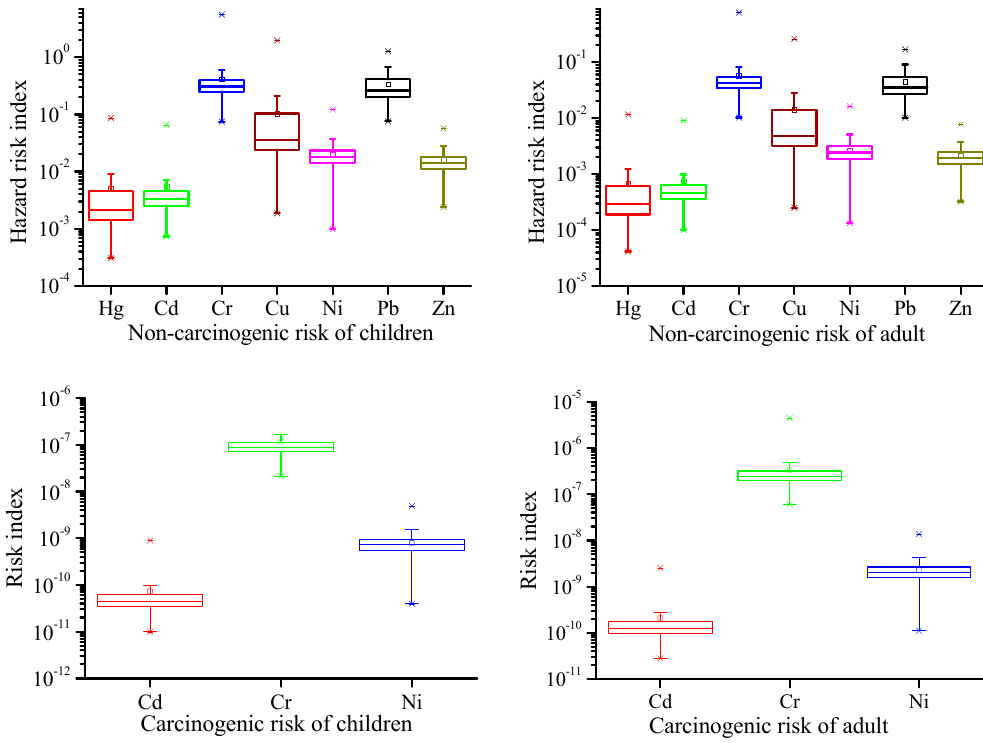
Figure 4. Non-carcinogenic and carcinogenic hazard index for heavy metals from settled dust in Qingdao. The illustration of boxplot is same to Figure 3.